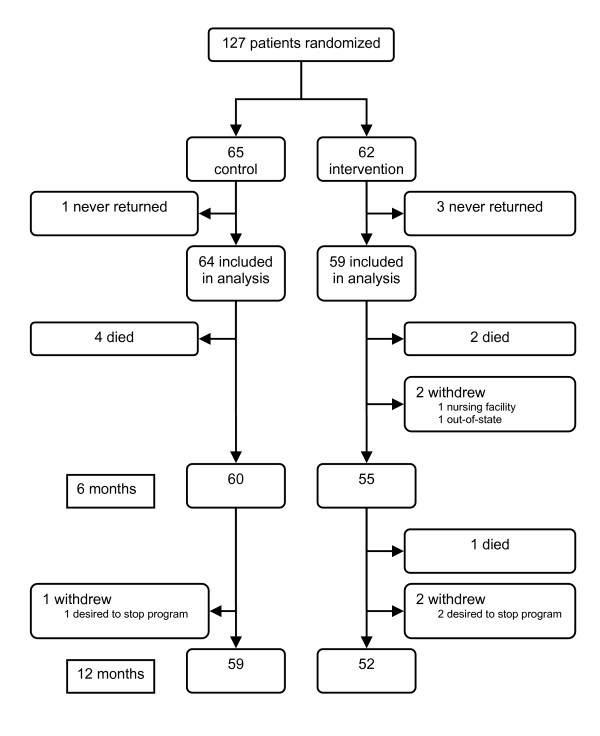
Patient flow during the study.